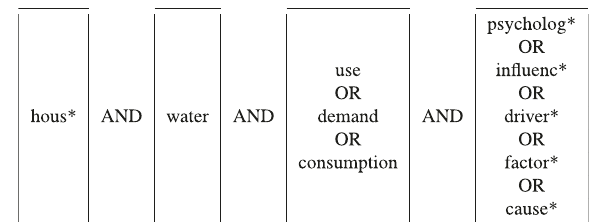
Fig. 1 Keywords used in literature search. The represented query was used to search for papers on the determinants of household water consumption published in the last 40 years and stored in the Elsevier “ Engineering Village ” databases 28 . Subject, title, and abstract fi elds were considered for the initial